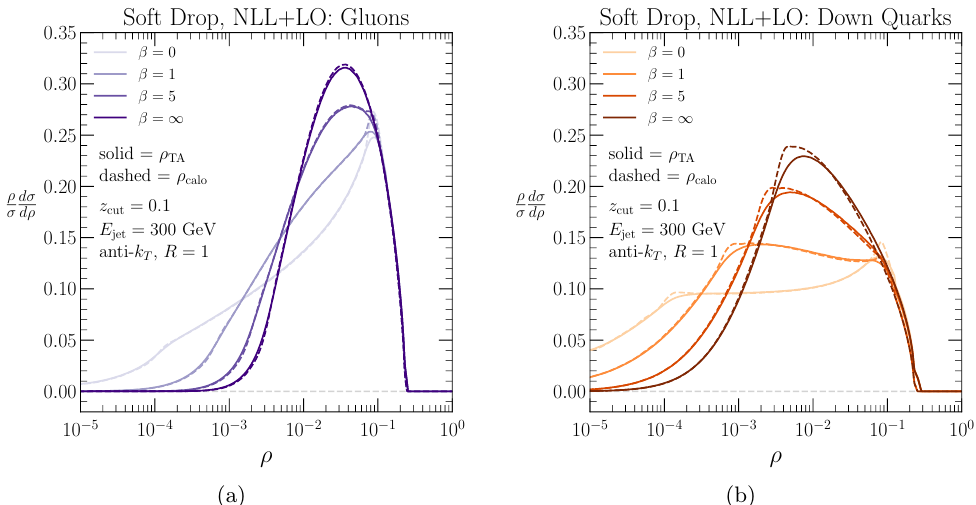
Figure 16 . Matched distributions for rescaled jet mass (cid:26) calo (solid curves) and rescaled track- assisted mass (cid:26) (dashed curves) after soft-drop grooming for (a) gluon jets and (b) down-quark TA jets. Shown are soft-dropped grooming parameters z cut = 0 : 1 and (cid:12) =